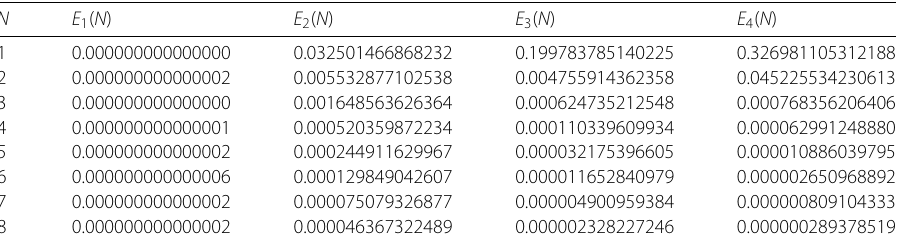
Table 2 The max error for Example 8.2 for α = 0.5